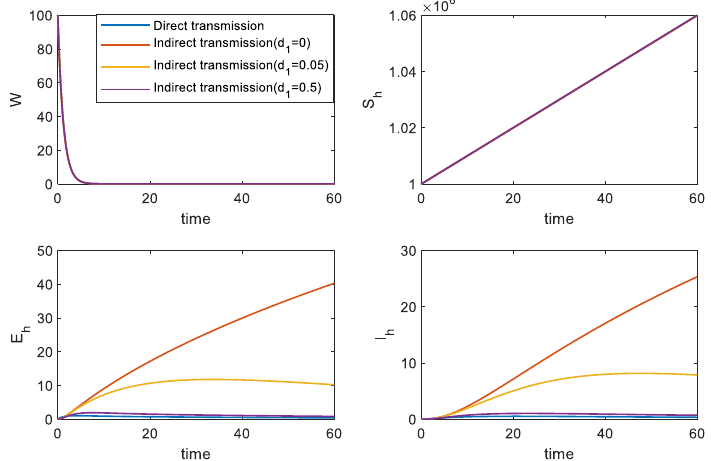
Figure 10. Changes in the numbers of W , S h , E h , and I h with different d and d w = 0.85 in model 2.